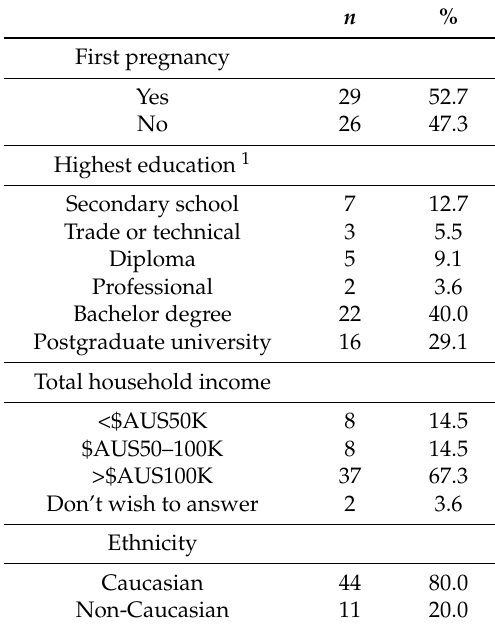
Table 1. Sociodemographic characteristics of study participants ( n = 55).